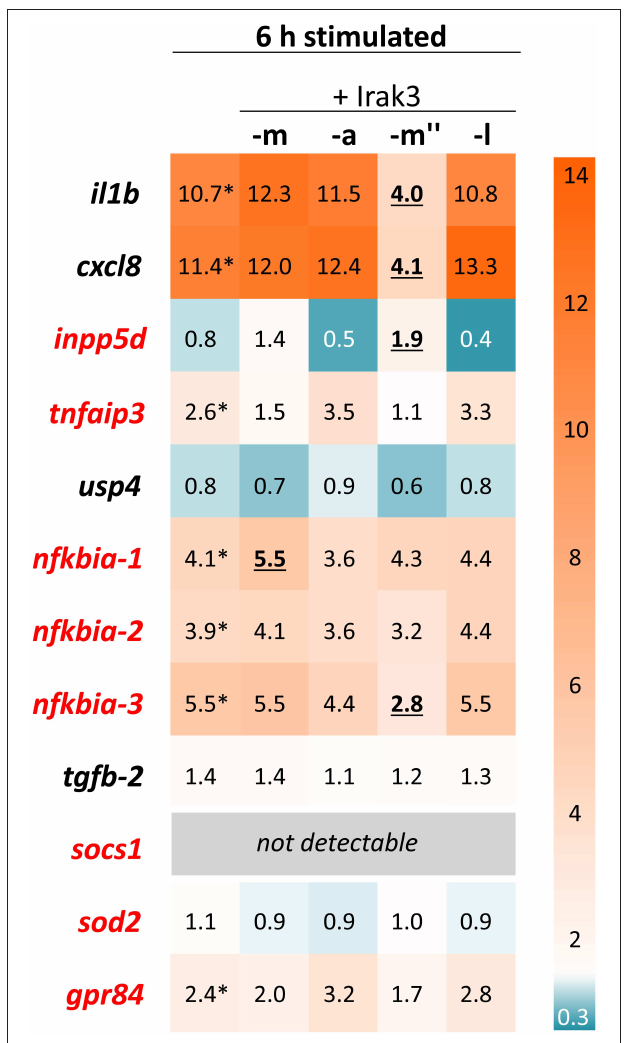
FIGURE 7 | Expression profiling of stimulated Irak3-overexpressing CHSE-214 cells. The HeatMap illustrates the averaged fold-change values (according to the legend on the right) of the mRNA concentrations measured in CHSE cells 6h after stimulation with 10 µ g/ml poly (I:C) and 100ng/ml flagellin, relative to unstimulated control cells (set as 1.0). The quantified transcripts are listed as gene symbols on the left; orthologs whose expression is IRAK3-dependent in mammals according to Zhou et al. (5) are highlighted in red. Significant copy-number changes ( p < 0.05) of stimulated vs. non-stimulated untransfected cells are marked with asterisks; significant copy-number changes of stimulated non-transfected vs. transfected cells are underlined. All expression values were normalized against the geometric means of the reference genes eef1a1 and rps5